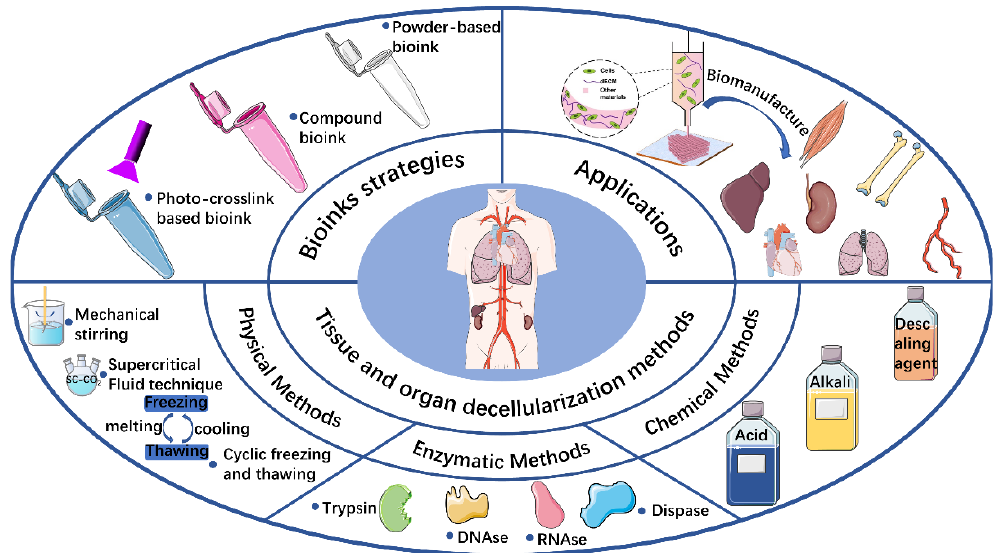
Figure 1. Schematic illustration highlighting the various decellularized extracellular matrix (dECM) preparation methods, and the bioink preparation strategies and applications of 3D bioprinting dECM-based bioinks in tissue engineering.